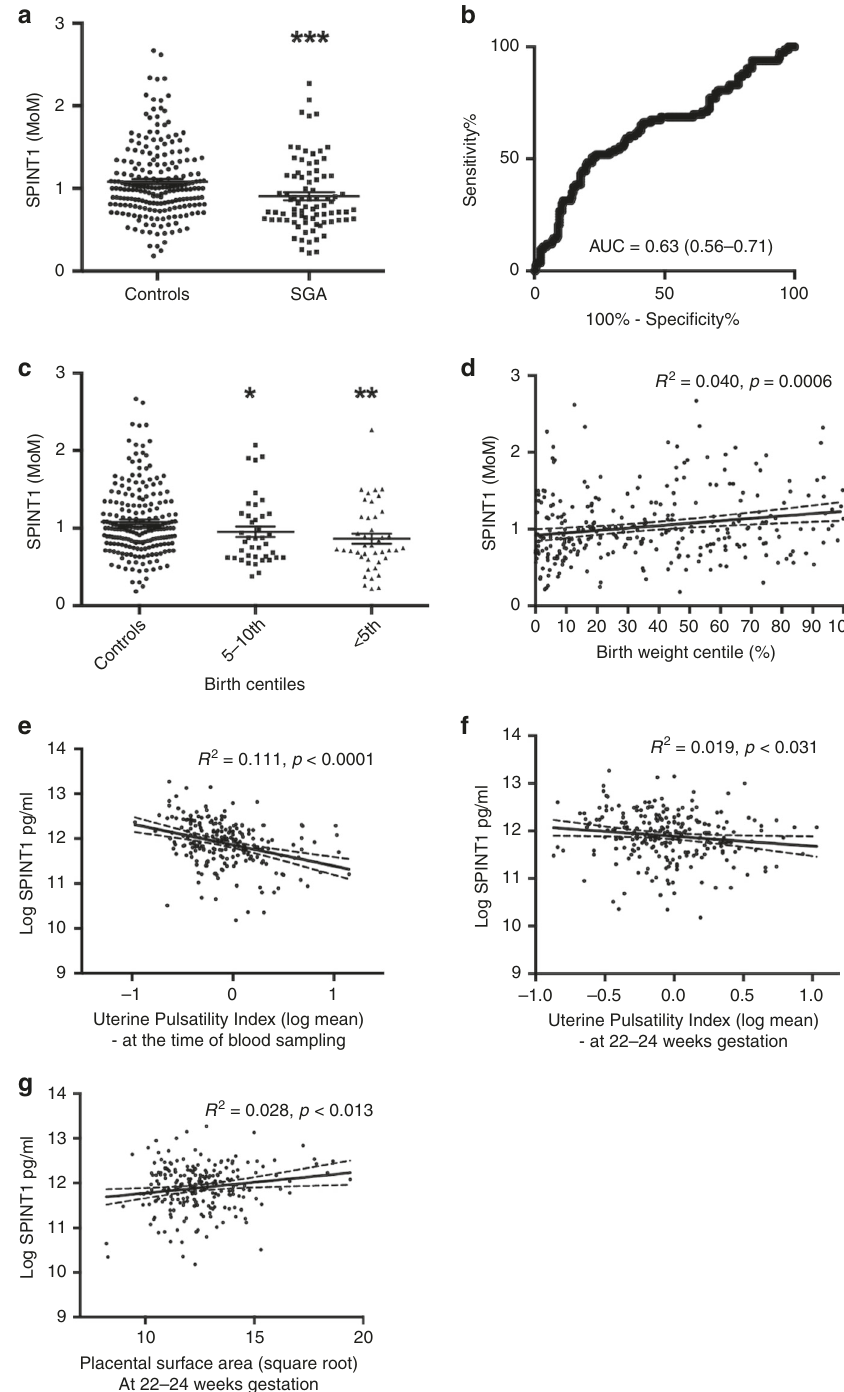
Fig. 3 SPINT1 is reduced in an independent high-risk cohort. Plasma SPINT1 levels were assessed in samples from women who presented at the Manchester Antenatal Vascular Service (MAViS). SPINT1 is reduced in the SGA cohort ( a , b , p = 3.31 × 10 − 4 ), with a step-wise reduction when SGA cases were split into 5 – 10th and <5th centile ( c , 5 – 10th p = 2.83 × 10 − 2 vs control, <5th p = 1.10 × 10 − 3 vs control). We also con fi rm that circulating SPINT1 correlates across all birthweight centiles ( d ). Uterine artery pulsatility index was assessed at the time of blood sampling, as well as at 22 – 24 weeks, and for both of these measures we demonstrate a signi fi cant correlation with circulating SPINT1 ( e , f ). We also con fi rm a signi fi cant correlation between circulating SPINT1 and estimated placental surface area at 22 – 24 weeks. For all panels, each individual symbol represents one patient. a , b : n = 208, control, n = 83 SGA. c : n = 208 control, n = 40 5 – 10th, n = 43 < 5th. e : n = 221, f : n = 244, g : n = 223. * p < 0.05, ** p < 0.01 using